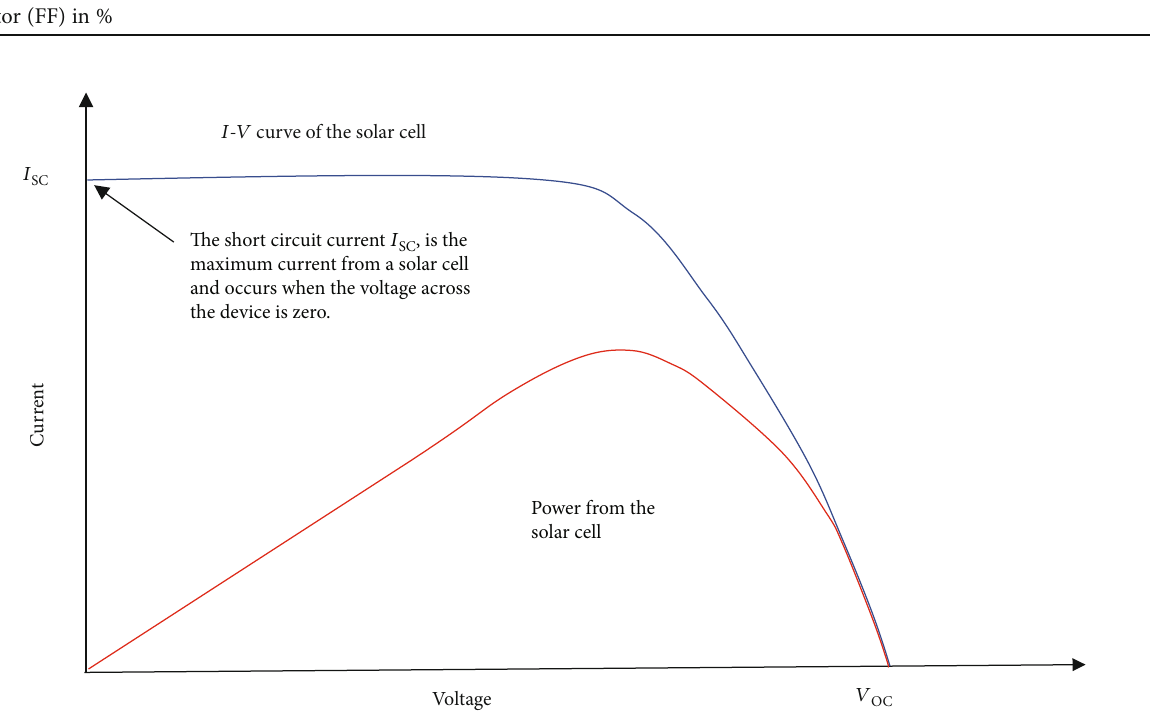
Figure 13: Typical I − V and P − V curves [72].